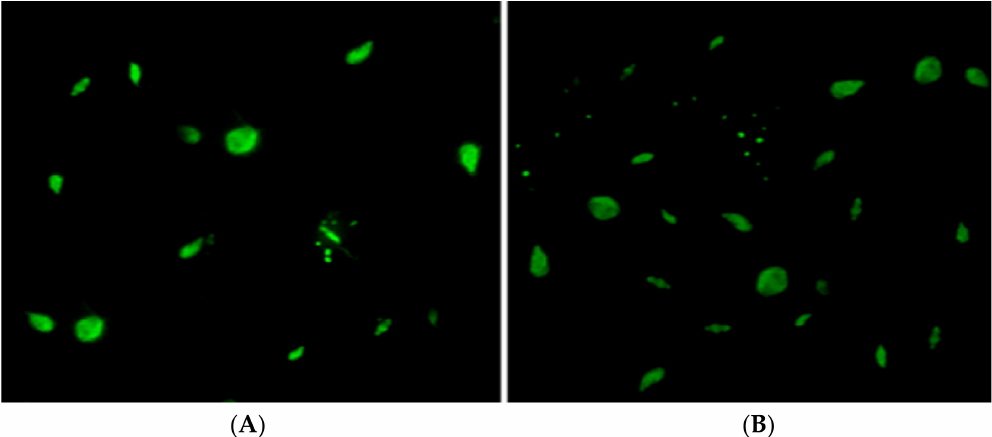
Figure 6. Apoptosis of Leishmania tropica cells treated with ( A ) compound 1 and ( B ) compound 2 using acridine orange fluorescent staining. Image after 48 h of treatment; dull green nuclei are indicative of